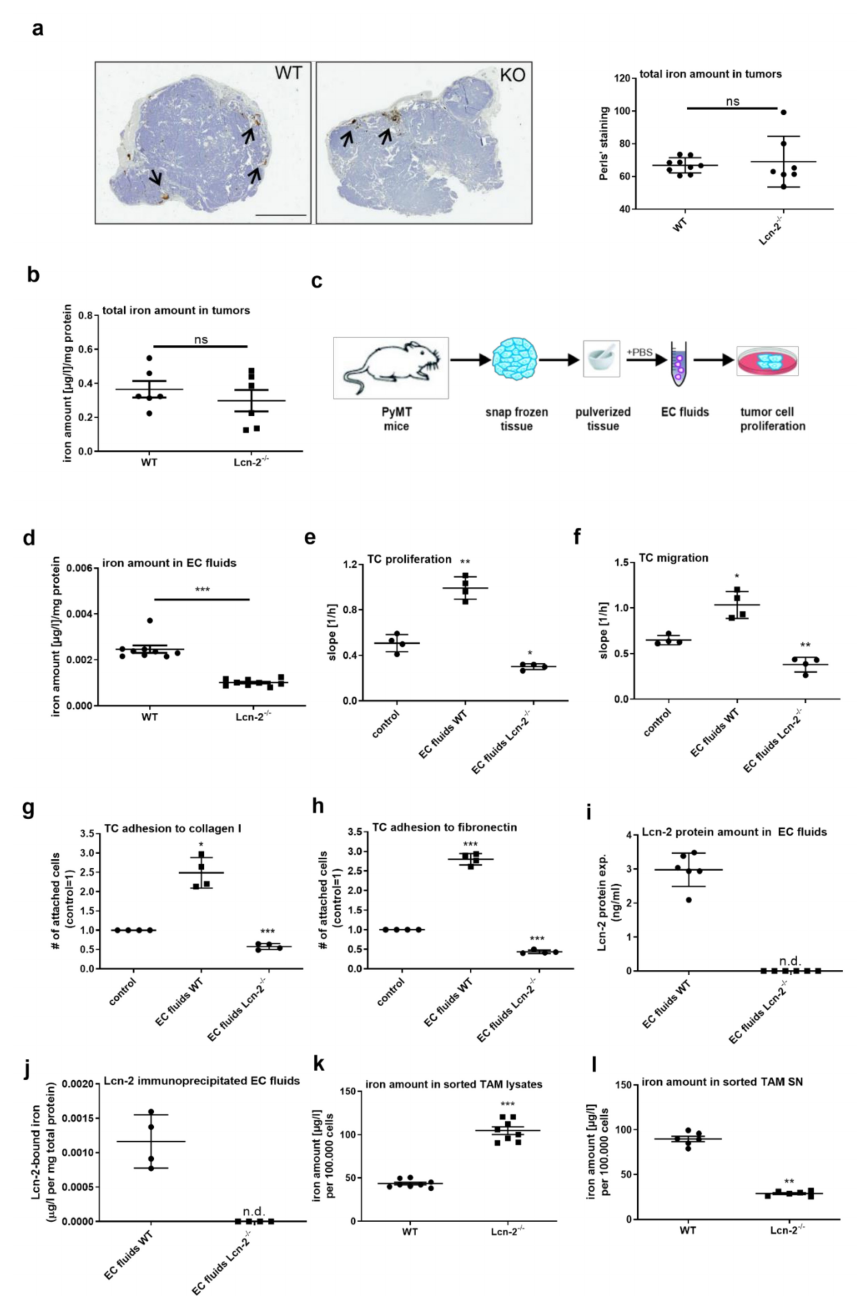
Figure 3. Lcn-2 − / − extracellular tumor fluids (EC fluids) inhibit tumor growth and metastasis. ( a ) Determination of the overall iron amount in tumors from WT and Lcn-2 − / − (KO) PyMT mice by ( a , left) Perls’ staining and ( a , right;) quantification of the Perls’ staining intensity using ImageJ. Scale bar: 6 mm ( b ) Quantitative iron measurement by atomic absorption spectroscopy (AAS). ( c ) Isolation of extracellular fluids from WT and Lcn-2 − / − PyMT tumors and ( d ) quan- tification of the iron content in EC fluids by AAS. ( e ) Effect of EC fluids from WT or Lcn-2 − / − tumors on ( e ) cellular proliferation and ( f ) migration of primary WT PyMT tumor cells (TC) using the xCELLigence real-time measurement system. ( g , h ) Adhesion assay of PyMT tumor cells (TC) stimulated with WT or Lcn-2 − / − EC fluids using collagen I and fibronection as matrix to demonstrate the metastatic potential. ( i ) Analysis of the Lcn-2 protein content in wildtype EC fluids by ELISA. ( j ) Quantification of the Lcn-2-bound iron by AAS after immunoprecipitation of Lcn-2 from EC fluids. ( k ) Intracellular iron amount in TAM isolated from WT and Lcn-2 − / − tumors compared to ( l ) the secreted amount of iron in the supernatant. Graphs are displayed as means ± SEM. Statistically significant differences were calculated after analysis of variance (ANOVA) and Bonferroni’s test ( a , b , d , i – l ) or Students t -test ( e – h ), with * p < 0.05, ** p < 0.01, *** p < 0.001. ns: not significant; n.d.: not